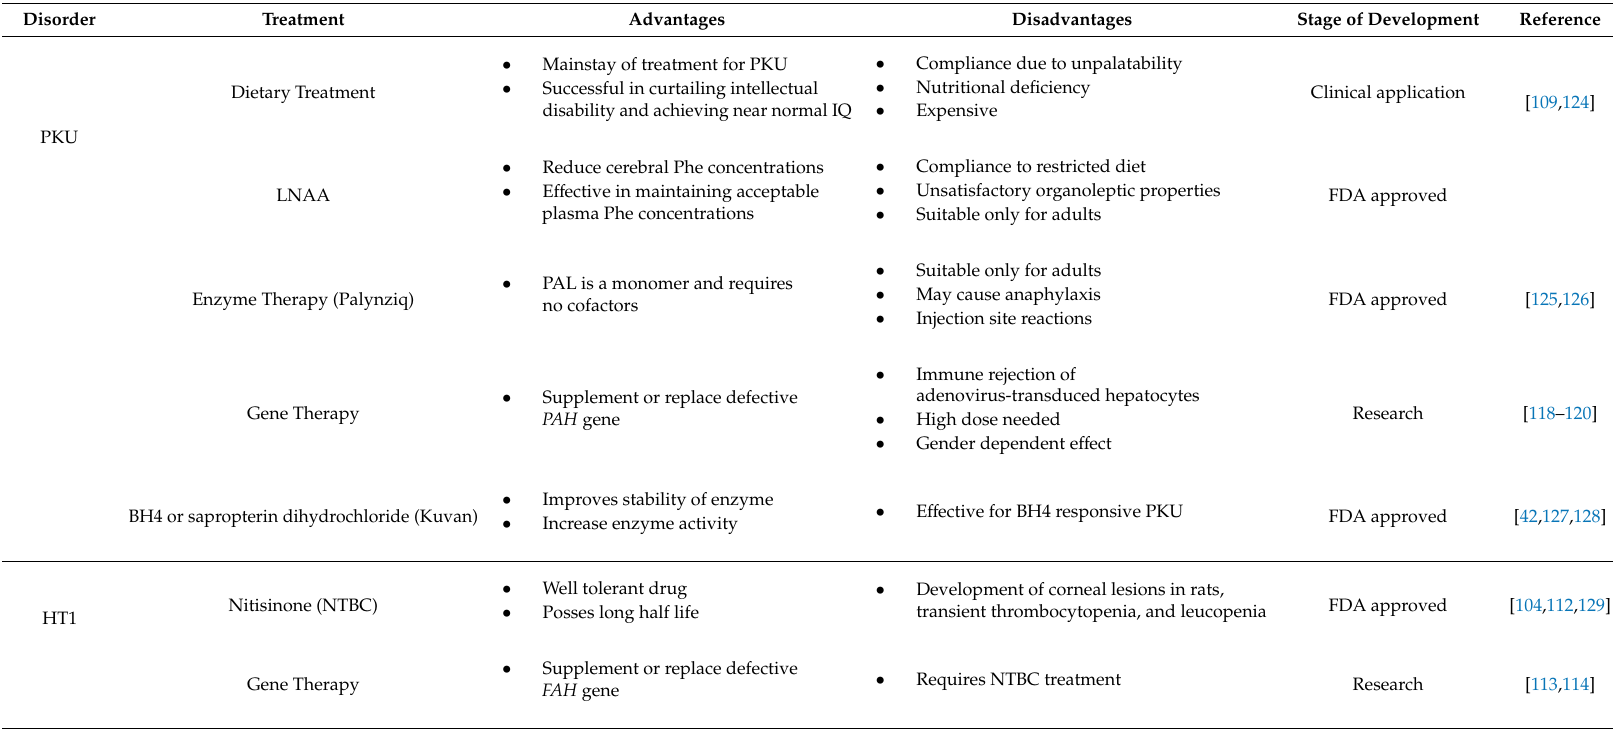
Table 1. Therapeutic regimes in phenylketonuria (PKU) and hereditary tyrosinemia-I (HT1).